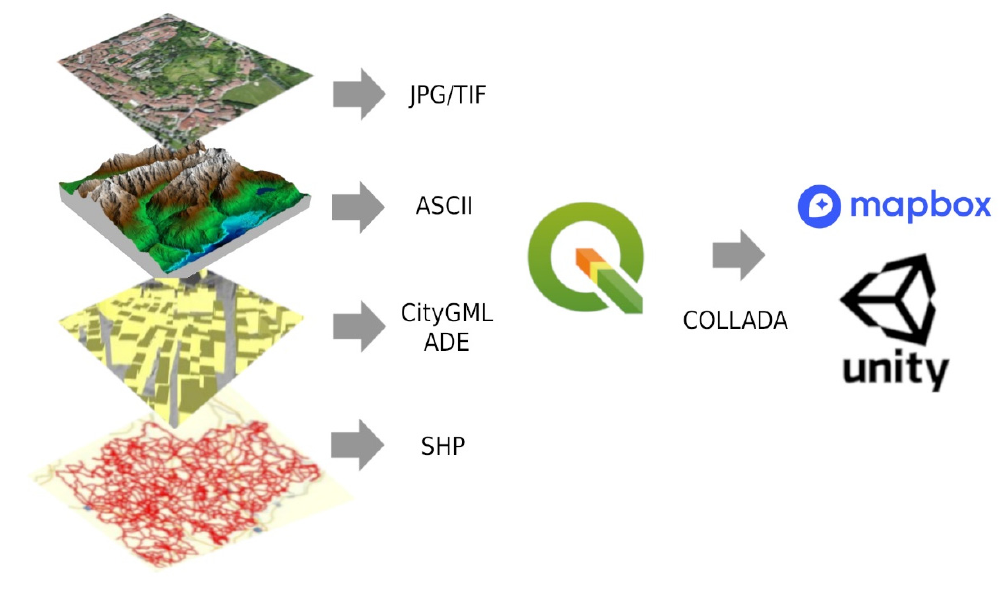
Figure 4. Open-source production pipeline.